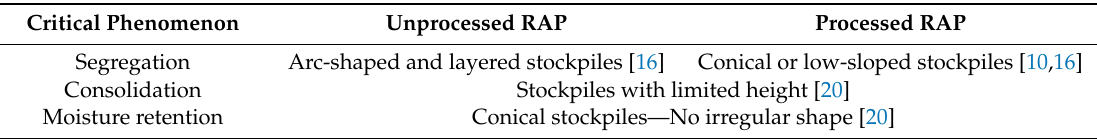
Table 2. Recommended geometric shape of the unprocessed and processed RAP